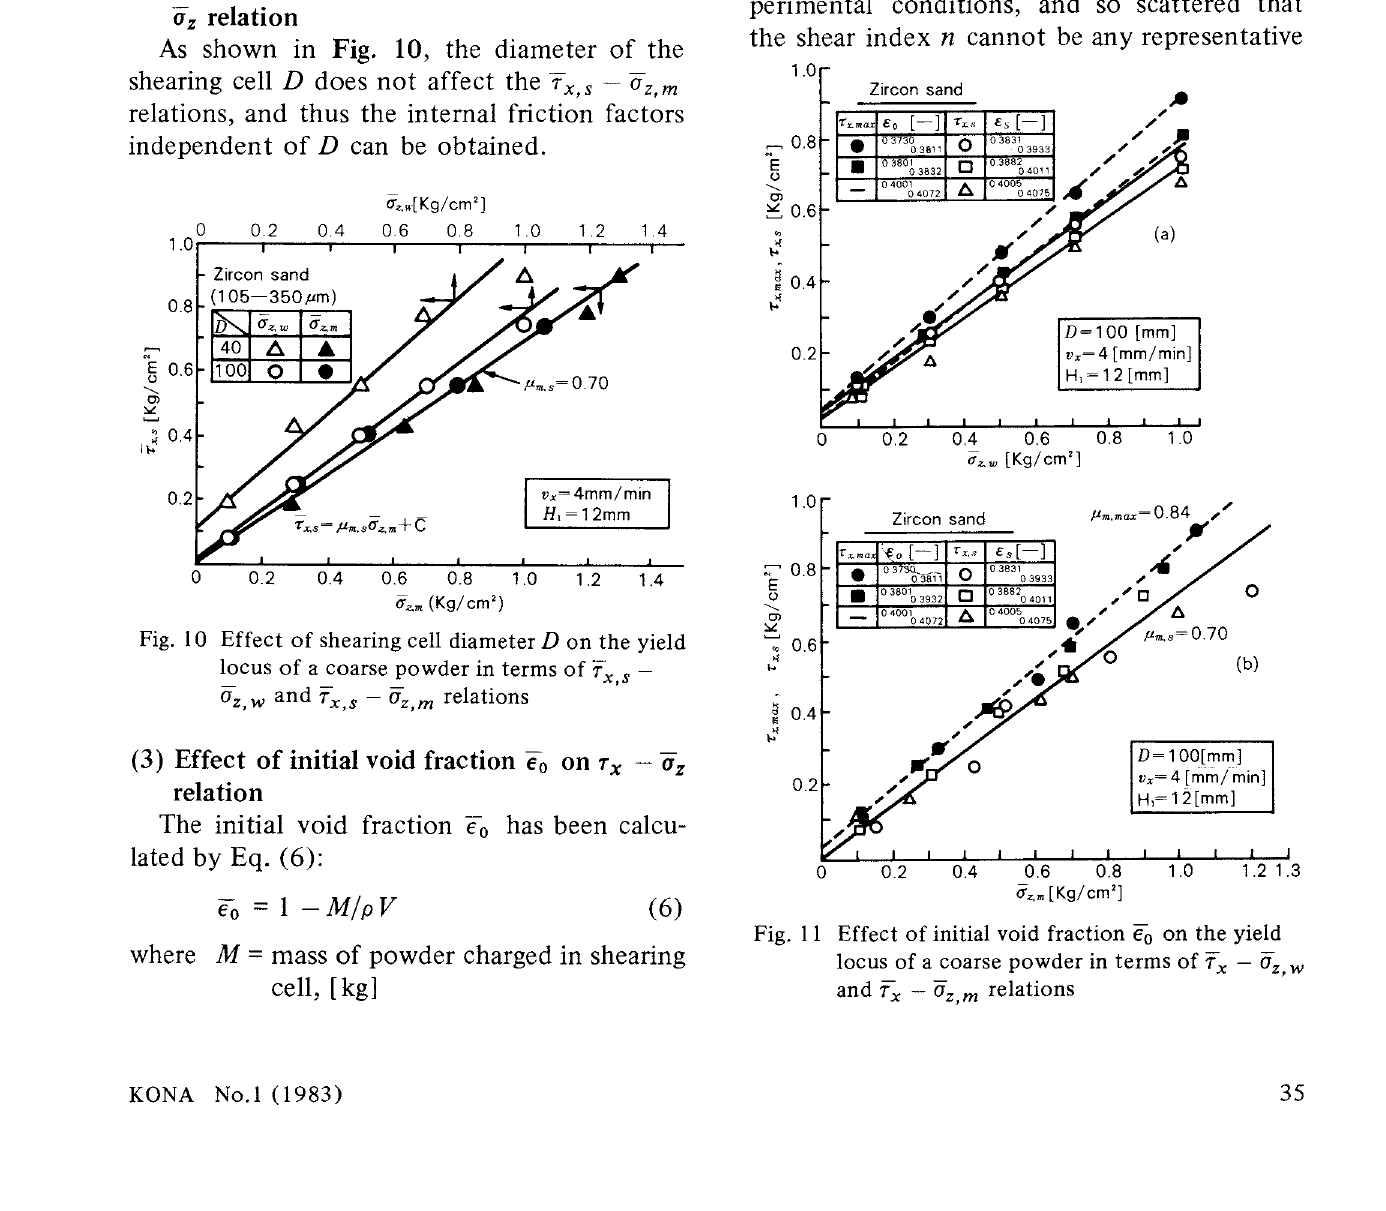
Fig. 9 Effect of upper powder bed height H yield locus of a fine powder in terms of 7;; s - Oz,w and Tx,s- Gz,m relations '